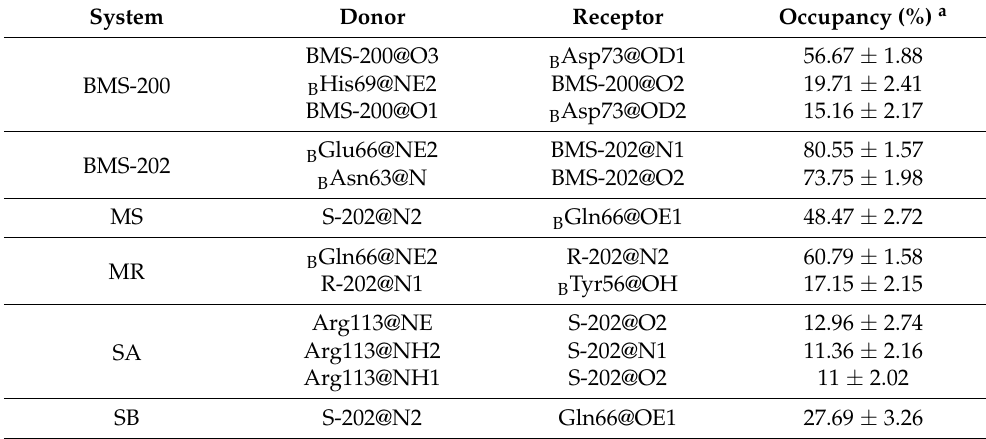
Table 3. Hydrogen bond occupancy of the